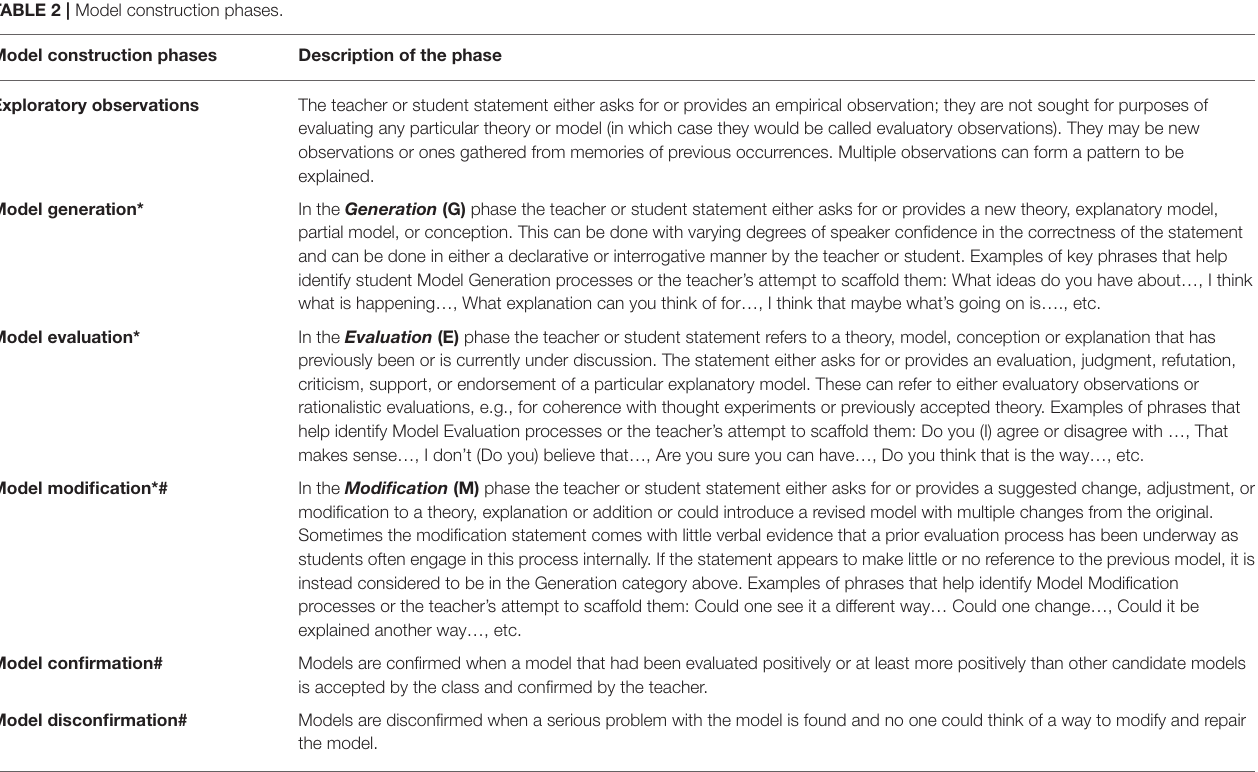
TABLE 2 | Model construction